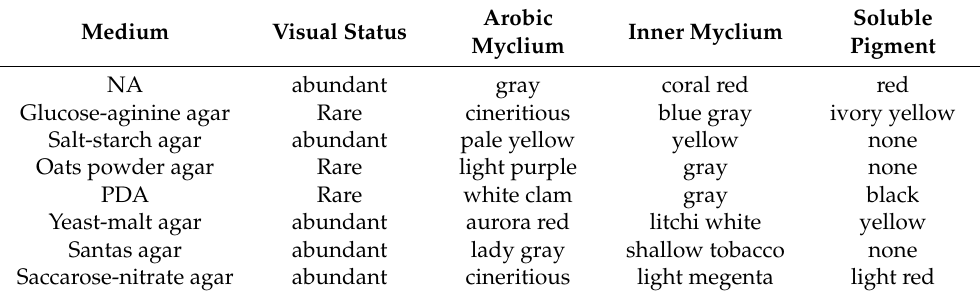
Table 1. Cultural characteristics of strain TXC6.